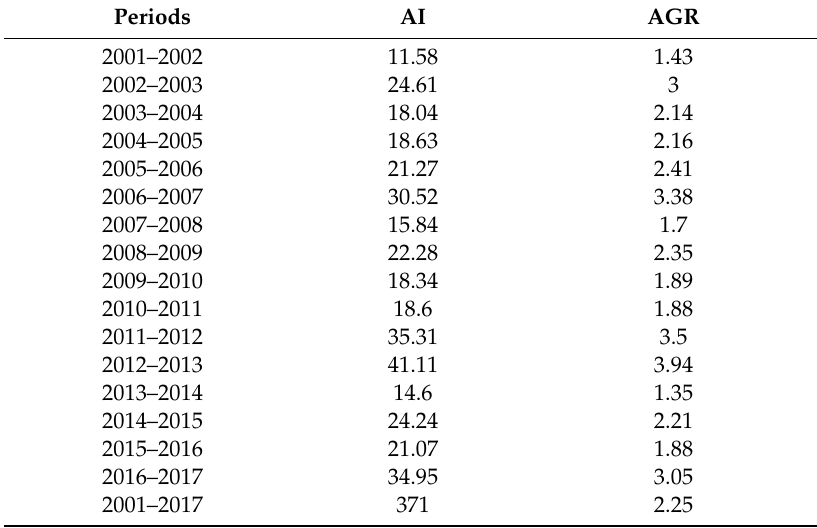
Table A3. Annual increase (AI) impervious surface area (km 2 ) and annual growth rate (AGR) (%) for CZTUA among 2001 to